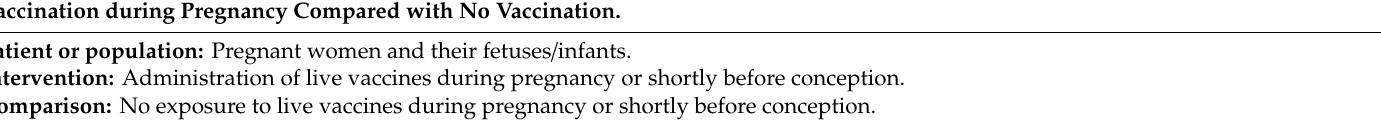
Table 2. Summary of